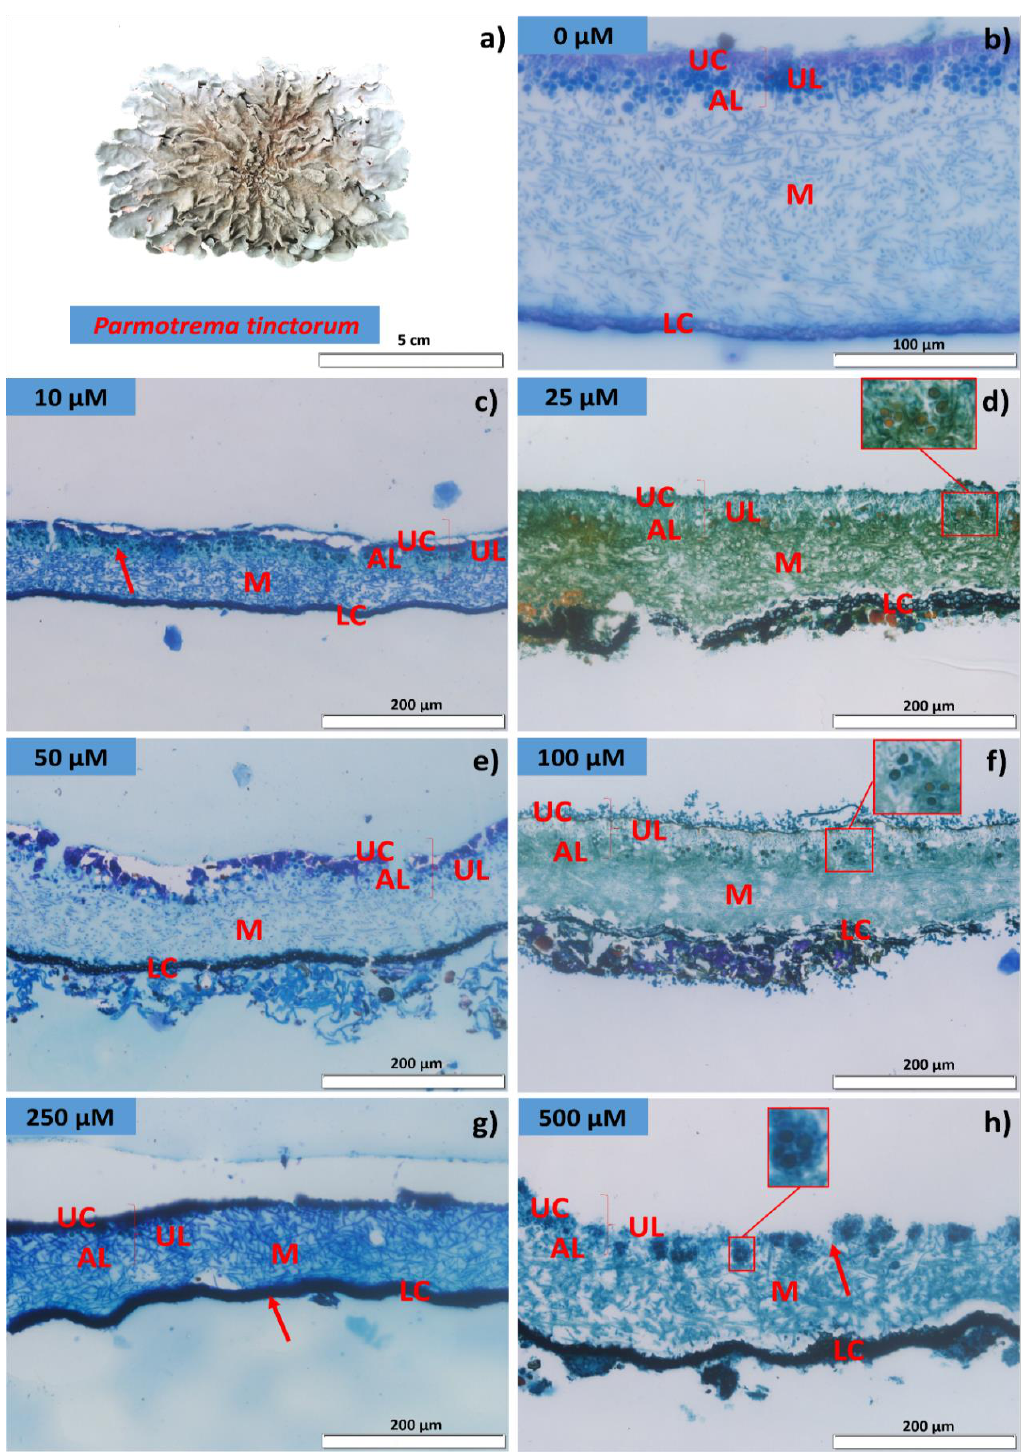
Figure 2. Anatomical sections showing the tissue organization of the thallus of the lichen Parmotrema tinctorum subjected to different concentrations of the heavy metal cadmium (0, 10, 25, 50, 100, 250, and 500 µM). Parmotrema tinctorum ( a ), anatomical layers ( b , e ), UC = upper cortex, AL = algal layer, UL = upper layer (upper cortex + photobiont layer), M = pith, and LC = lower cortex. In ( c , g ), arrows indicate intensely stained algal cells and the lower cortex. In ( h ) the arrow indicates anatomical disaggregation of the upper cortex. In ( d , f , h ), the smaller frames highlight the differential orange pigmentation.